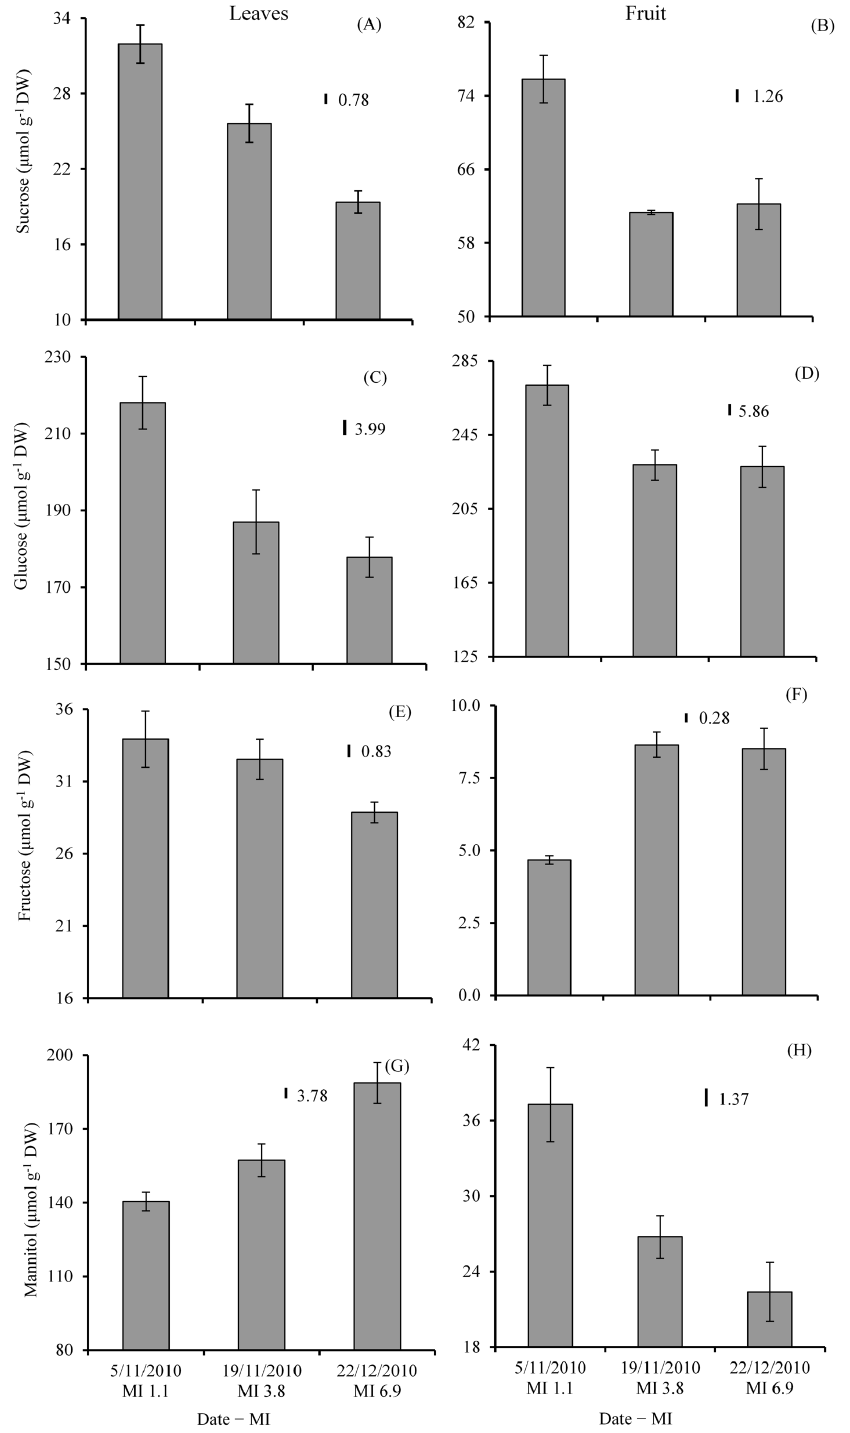
Fig. 2: Sucrose, glucose, fructose and mannitol, in leaves and fruit, in response to seasonal development and fruit maturity indices (MI) in Koroneiki olive fruit, in 2010. A, C, E and G, leaves; B, D, F and H, fruit. Bars without numbers correspond to standard deviations; bars with numbers to Standard Errors from the residual variance (ANOVA) of three replicates, d.f. = 6. In E, P < 0.05, in D, P < 0.01, whereas in A, B, C, F, G and H, P < 0.001 in all of sucrose concentrations were highest in February, but declined there- nant carbohydrate in leaves, and this agrees with the present results after, exhibiting fluctuations (B USTAN et al., 2011). In November, for December, but disagrees with the sugars determined earlier here, leaf mannitol and sucrose were approximately 236 and 117 μ mol g -1 when glucose was found at higher levels than mannitol. Indicatively, DW, respectively, with both sugars being much higher than found in other olive studies, the molar ratio of glucose/mannitol was 1.9 here. According to the findings in Barnea, mannitol is the predomi -